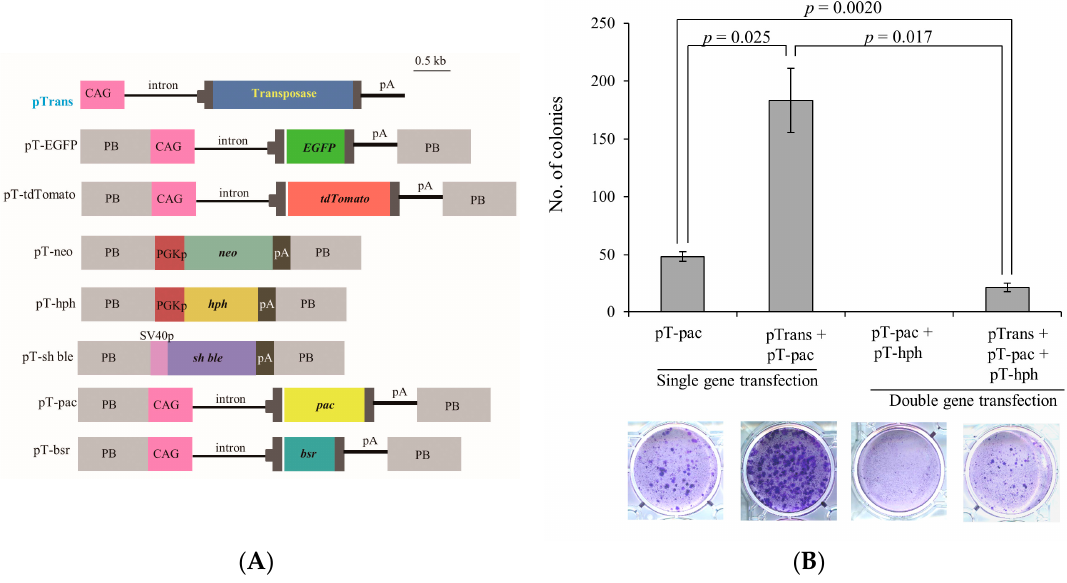
Figure 1. ( A ) Schematic representation of selectable marker expression vectors. Plasmid backbone